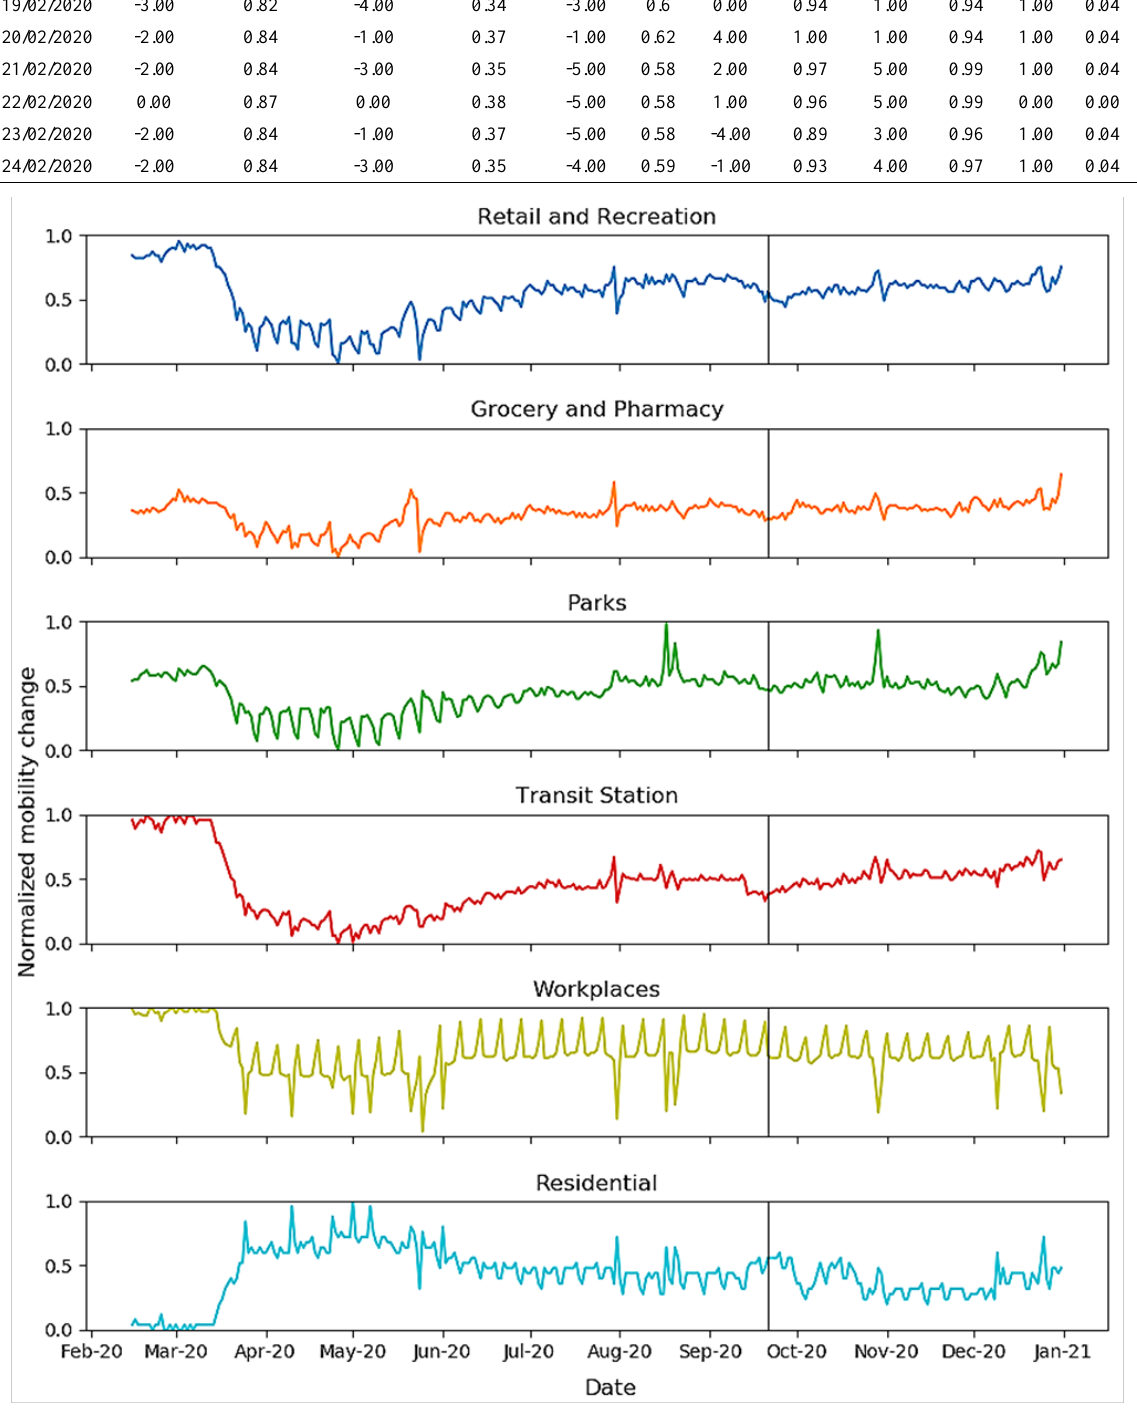
Figure 6. Plots of The Google Community Mobility Reports ranging from February 15 to December 31, 2020, in Indonesia. The first 120 days is used as training set while the last 102 days is used as test set. The training and testing part is separated by the vertical